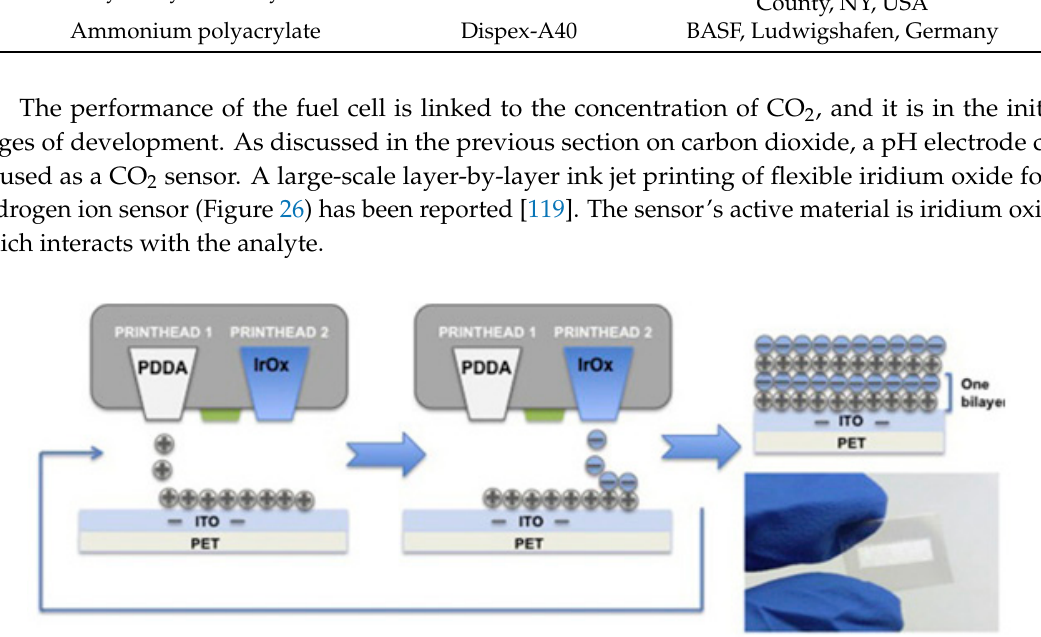
Figure 26. Deposition of positively charged poly(diallydimethylammonium chloride) (PDDA, 20% wt. in water, medium molecular weight MW 200,000–350,000) and positively charged particles by inkjet printing. ITO: indium tin oxide glass; IrOx: iridium oxide; PET: polyethylene terepthalate. The feedback arrow indicates layer-by-layer deposition. Reproduced with permission from Reference